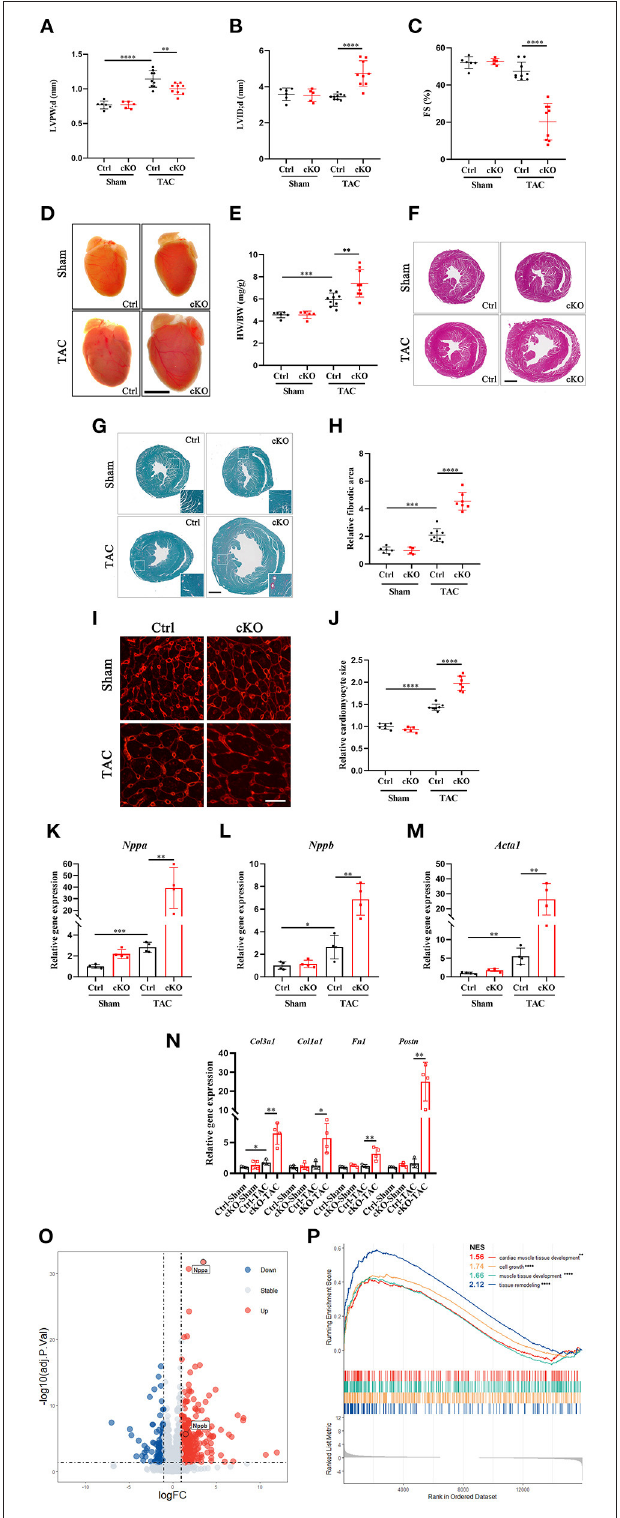
FIGURE 2 | Cardiac-specific knockout of METTL5 in vivo promotes TAC-induced cardiac remodeling. (A–C) Left ventricular posterior